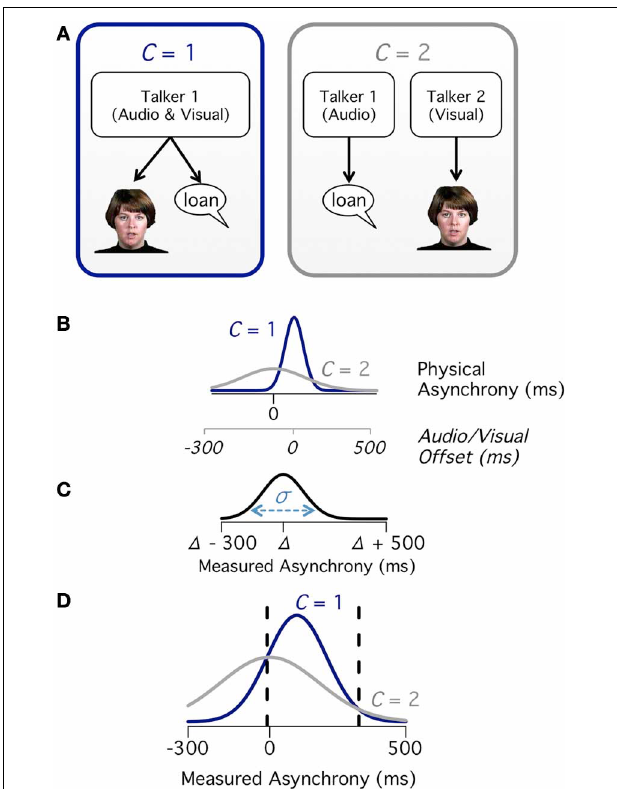
FIGURE 1 | Causal structure of audiovisual speech. (A) Causal diagram for audiovisual speech emanating from a single talker ( C = 1) or two talkers ( C = 2). (B) Difference between auditory and visual speech onsets showing a narrow distribution for C = 1 (navy) and a broad distribution for C = 2 (gray). The first x-axis shows the onset difference in the reference frame of physical asynchrony. The second x-axis shows the onset difference in reference frame of the stimulus (audio/visual offset created by shifting the auditory speech relative to the visual speech). A recording of natural speech without any manipulation corresponds to zero offset in the stimulus reference frame and a positive offset in the physical asynchrony reference frame because visual mouth opening precedes auditory voice onset. (C) For any given physical asynchrony ( (cid:2) ) there is a distribution of measured asynchronies (with standard deviation σ ) because of sensory noise. (D) Combining the likelihood of each physical asynchrony (B) with sensory noise (C) allows calculation of the measured asynchrony distributions across all physical asynchronies. Between the dashed lines, the likelihood of C = 1 is greater than the likelihood of C =